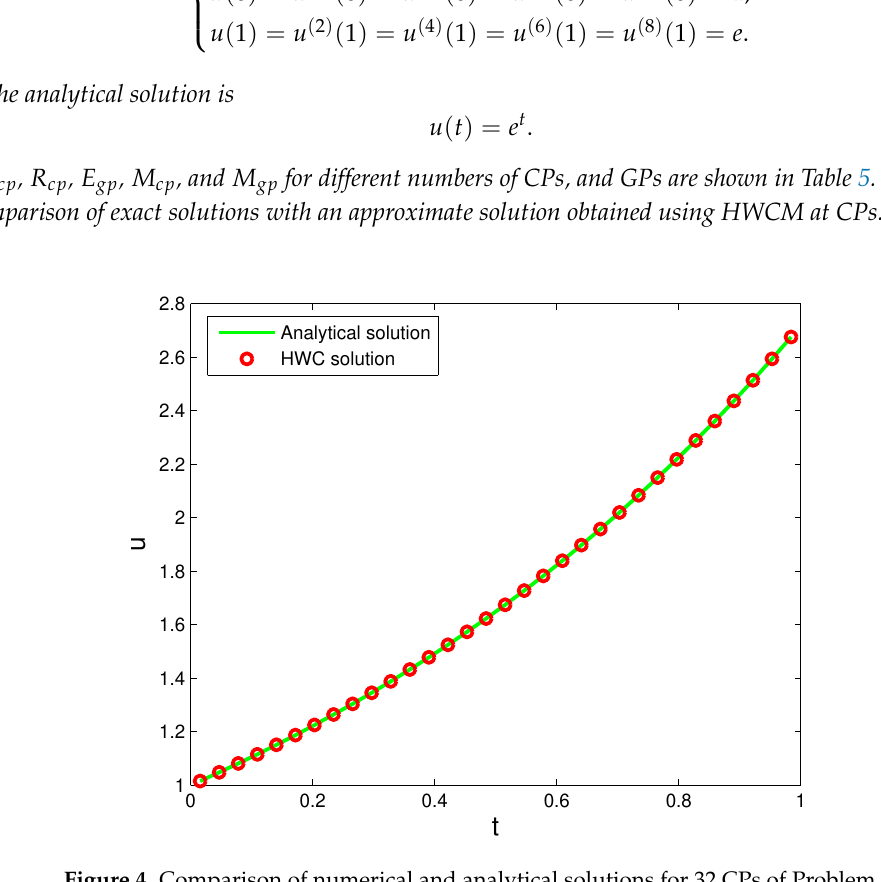
Figure 4. Comparison of numerical and analytical solutions for 32 CPs of Problem 4. Table 5. E cp , R cp , E gp , M cp and M gp for Problem